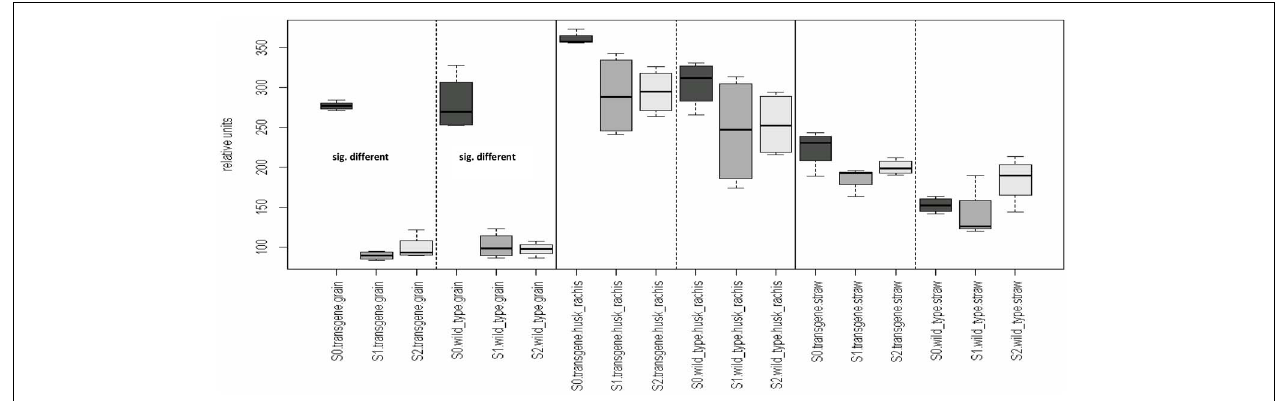
FIGURE 2 | Organ-specific effects of varying sulfur fertilization rates on the metabolome. Comparison of the means of the influence factor “S-fertilization rate” (S0, S1, S2) for each level of the remaining influence (genotpye and organs). Multiple contrast tests for ratios of means. Comparisons are indicated by the framed dotted lines. In the first comparison, the mean of group “S0, transgene, grain” differs from the mean